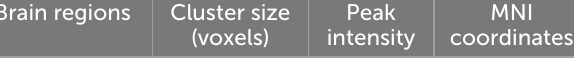
TABLE 2 Static [static amplitude of low-frequency fluctuations (sALFF), static regional homogeneity (sReHo)] and dynamic [dynamic amplitude of low-frequency fluctuations (dALFF), dynamic regional homogeneity (dReHo)] metrics inter-group differences between pontine infarction (PI) and healthy controls (HCs)